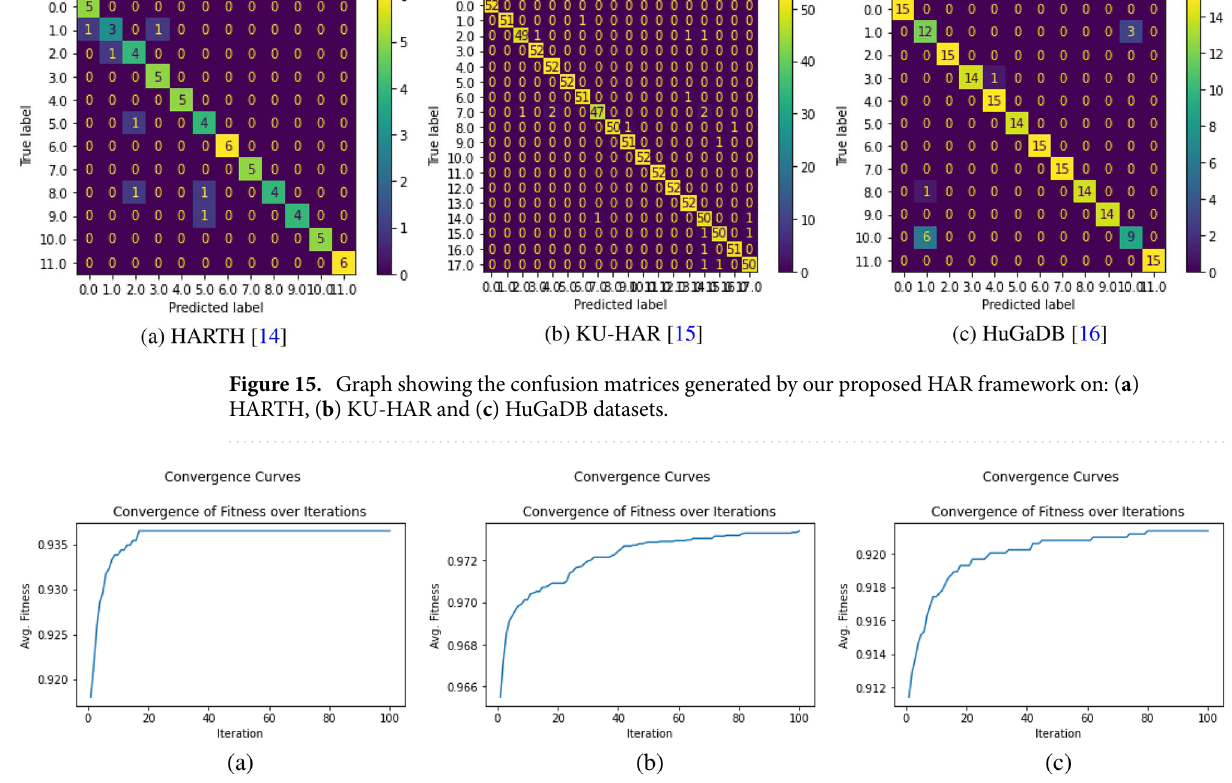
Figure 16. Convergence curves to show average fitness over iterations after applying BBA on concatenated feature set for: ( a ) HARTH dataset, ( b ) KU-HAR dataset and ( c ) HuGaDB